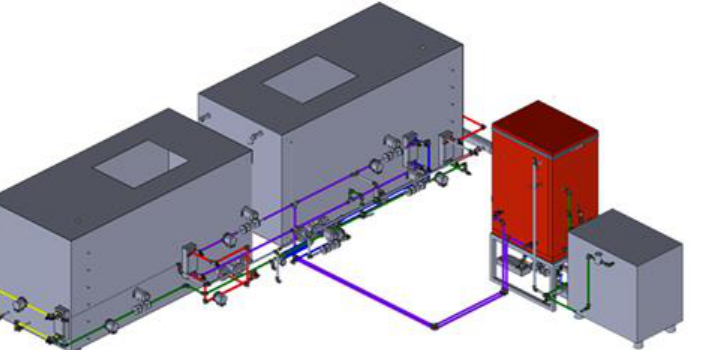
Figure 1. Three-dimensional, computer-aided design drawing of the lab-scale biohydrogen produc- tion system setup.